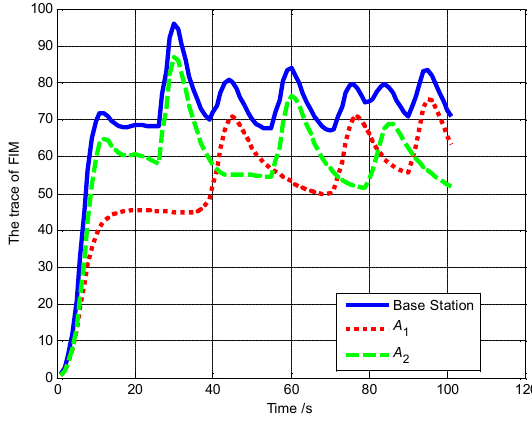
Figure 10. The track of FIM of A 1 , A 2 and base station (Group A in Scenario 1).